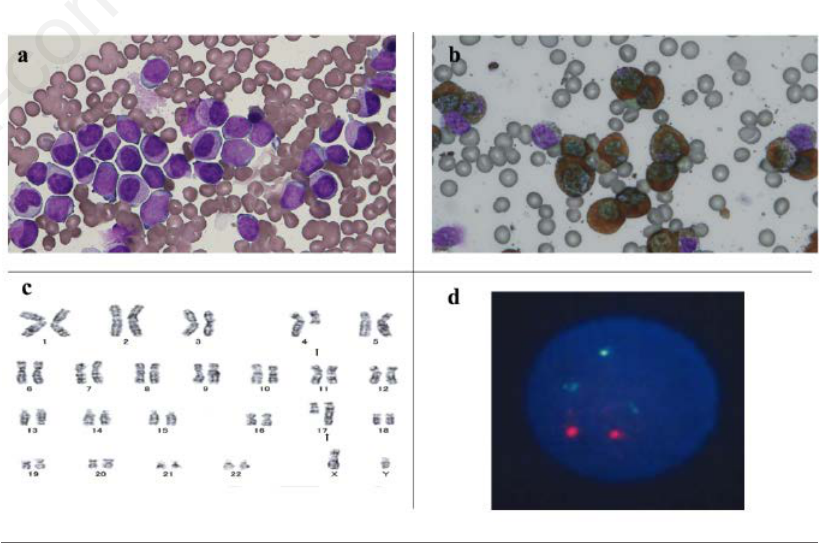
Figure 2. Morphological and cytogenetic analysis. a) Bone marrow smear showing myeloblasts and promyeloblasts (magnification: 600×). b) Myeloperoxidase staining was positive; however, the straining was not as strong as the typical acute promyelocytic leukemia (APL) pattern (magnification: 600×). c) Karyotype analysis revealed 46, XY, t(4;17)(q12; q21) in blast cells. d) Fluorescence in situ hybridization (FISH) of PML2:RARA3 was 34% positive; two intact signals for PML (red) and three split signals for RARA (green) were